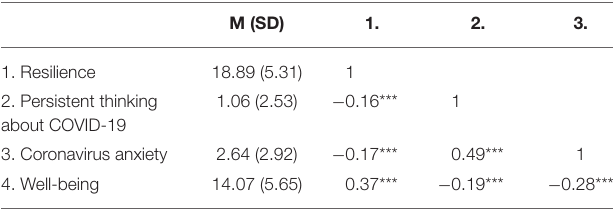
TABLE 1 | Descriptive statistics and correlations ( N =